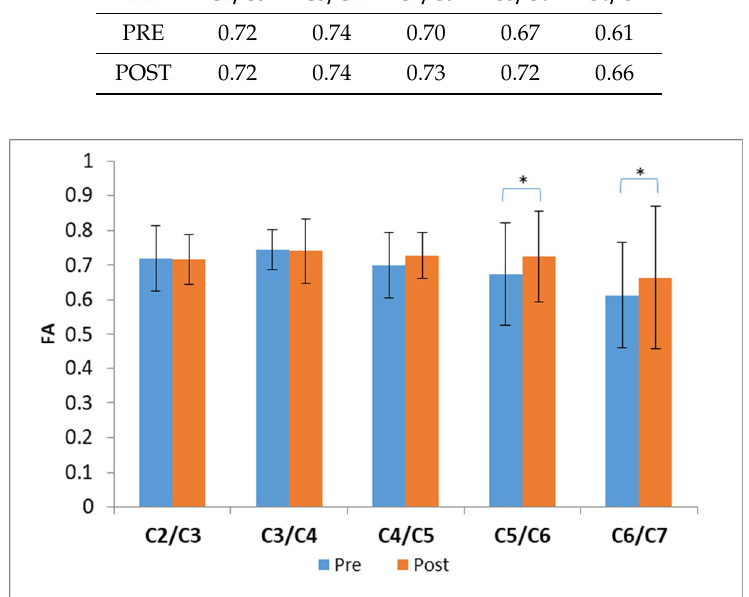
Figure 2. Fractional anisotropy (FA) values. Data are shown as mean values. The FA corresponding to the pre-surgery evaluation are shown in blue, whereas the FA corresponding to the post-surgery evaluation are shown in orange. Significant di ff erences are shown with * ( p <